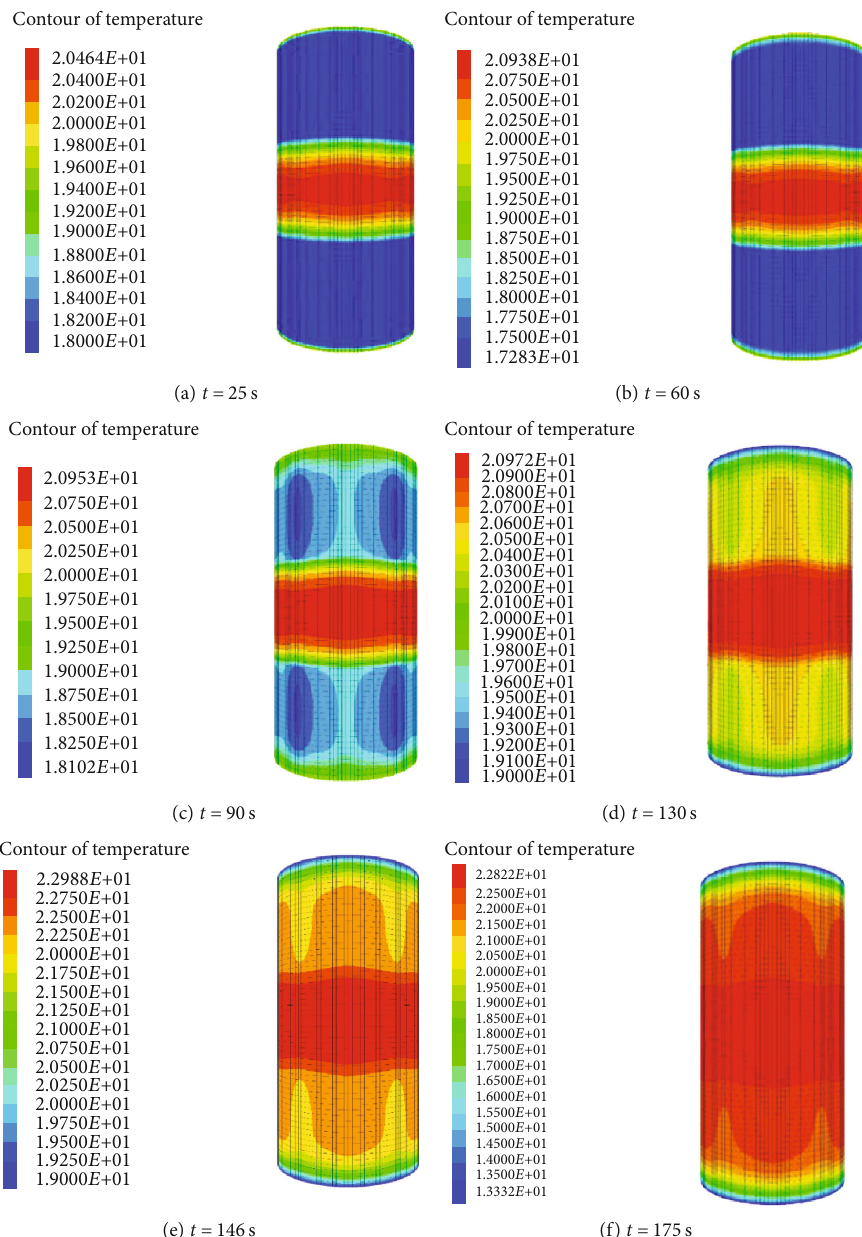
Figure 2: Cloud map of temperature distribution of composite coal-rock. When the simulation time is 25 s, 60s, 90 s, 130s, 146 s and 175s, cloud maps of temperature distribution of composite coal-rock at di ff erent times correspond to di ff erent stress stages in Figure 1, in which 146s is the time point after unloading con fi ning